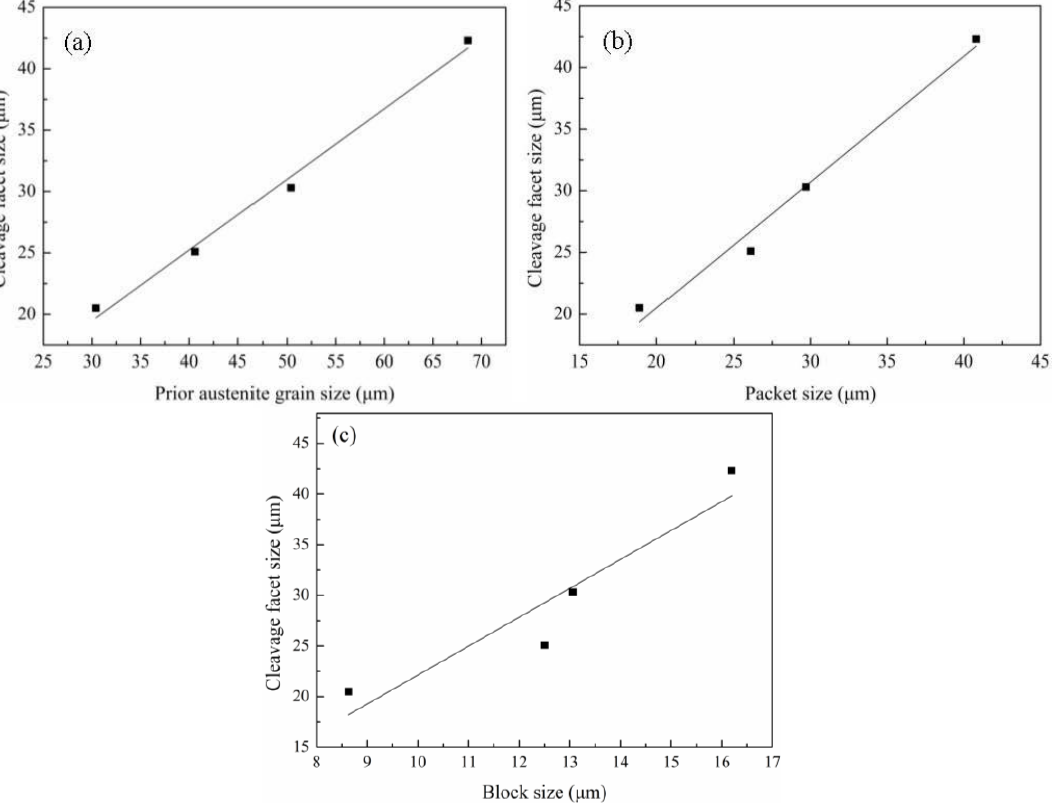
Figure 11. Cleavage facet size as a function of ( a ) prior austenite grain size; ( b ) bainite packet size; and ( c ) block width.